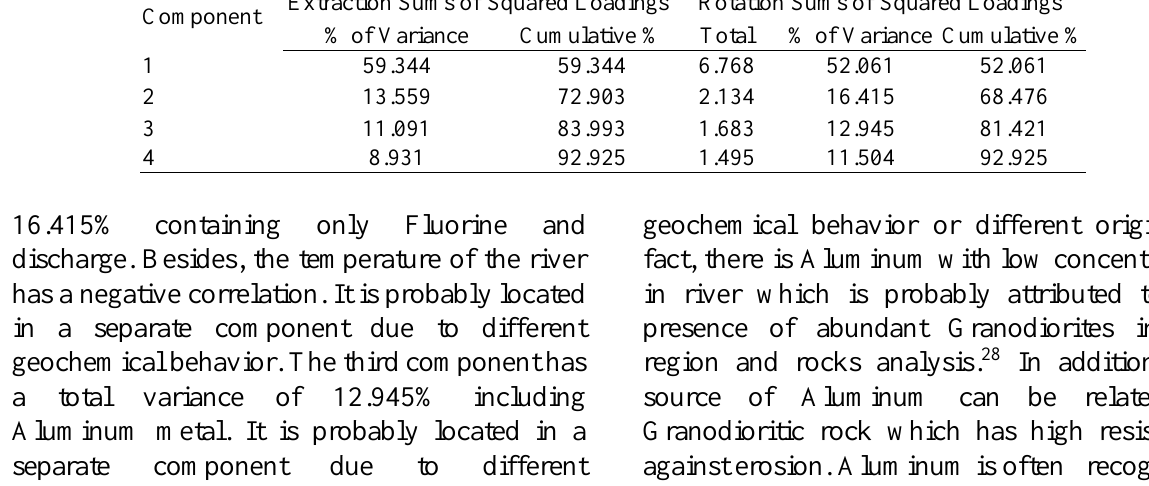
Table 6 Percentage of the total variance of extracted components Total Variance Explained